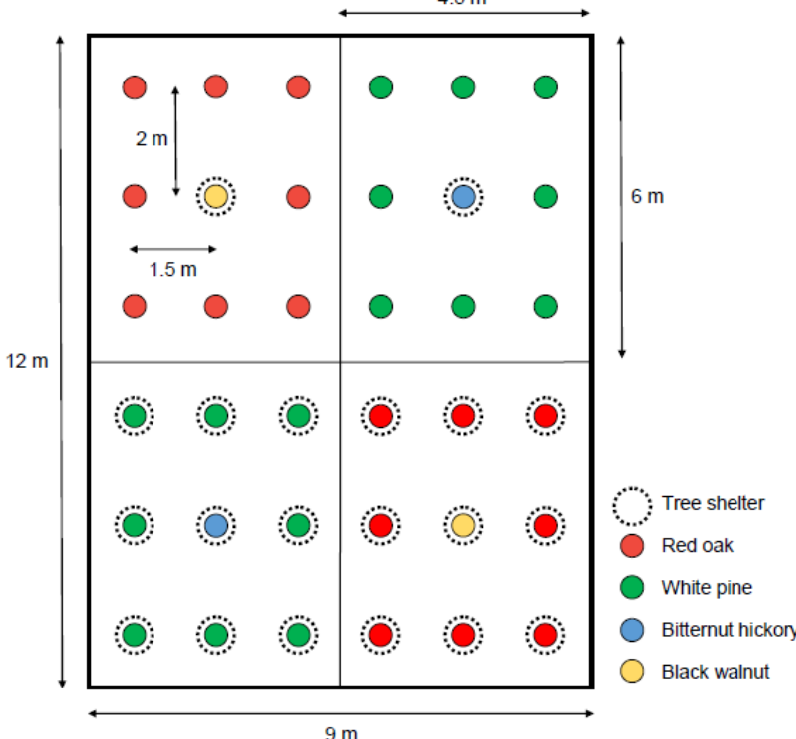
Figure 2. Schematic representation of a block with 4 experimental plots, one for each tree species (red oak or white pine)/deer protection treatments (tree shelter or control) combination. The position of each species/treatment combination was randomly assigned within each block. In the middle of each experimental plot, one bitternut hickory or one black walnut was planted and was protected with a tree shelter. The position of the two bitternut hickories and the two black walnuts within a block was always crisscrossed. The position of the first black walnut or bitternut hickory position was randomly assigned in the top left plot.